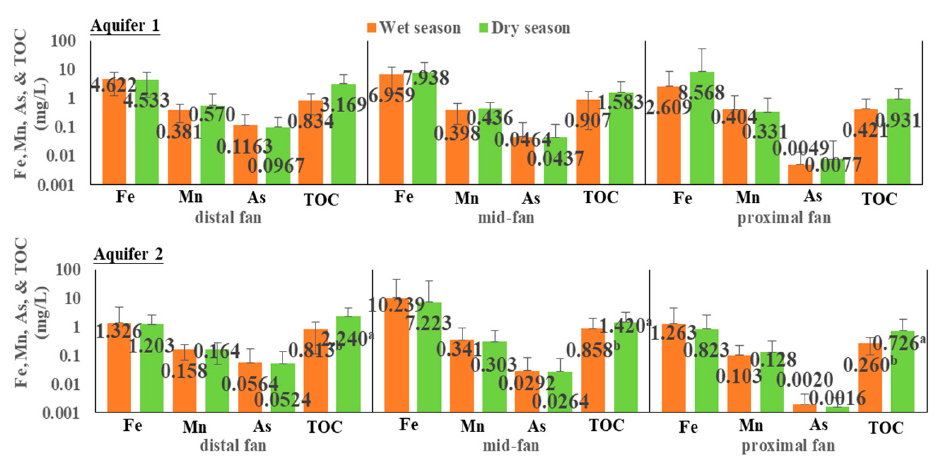
Figure 8. The mean concentrations of Fe, Mn, As, and TOC in addition to the statistical results of the proximal fan, mid-fan, and distal fan areas in both aquifers between the wet and dry seasons. (a superscript character after the mean value means that the water quality parameter has significant differences).